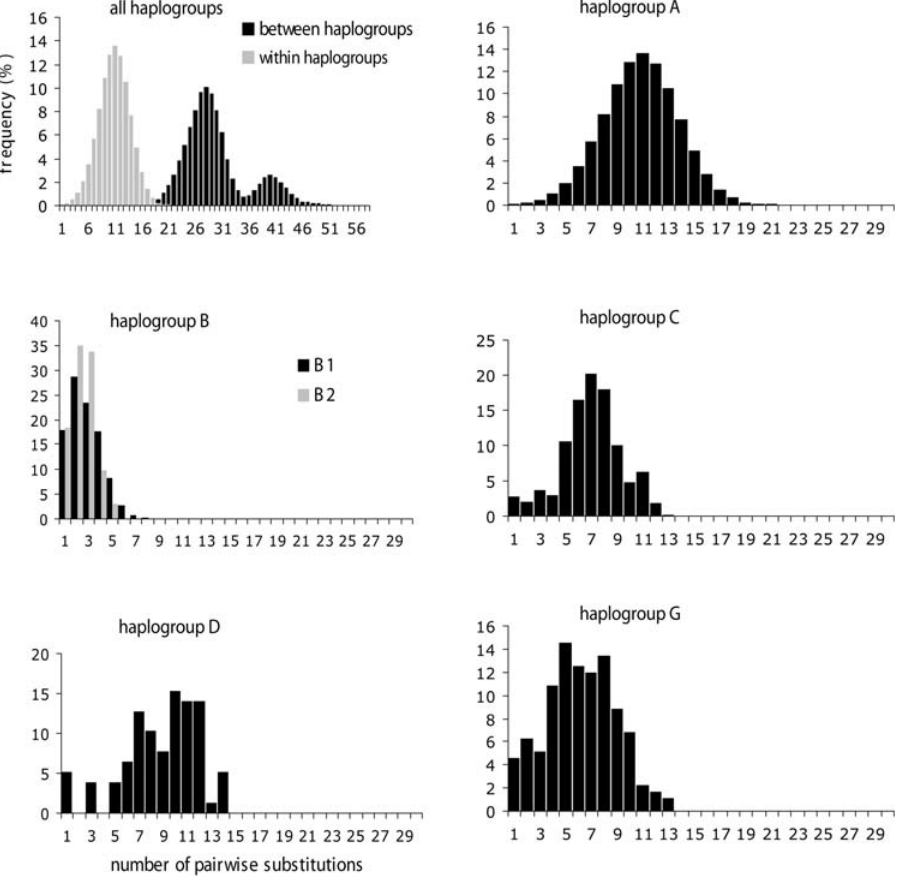
Figure 3. Mismatch distributions for mtDNA haplogroups of domestic goats. For the overall dataset, the distribution of pairwise differences were realized separately for comparisons between and within haplogroups. doi:10.1371/journal.pone.0001012.g003 PLoS ONE |